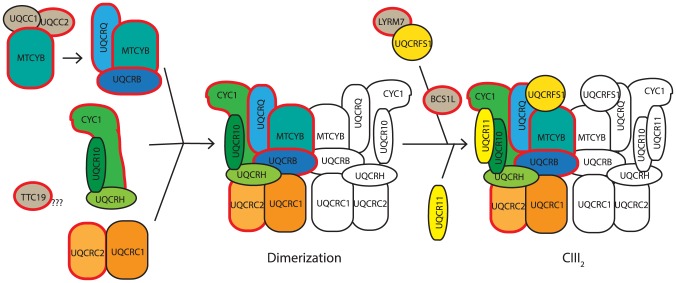
Proposed model of CIII assembly.Complex III assembly begins with the translation activation and/or stabilization of cytochrome b (MTCYB) by UQCC1:UQCC2, which then delivers MTCYB to an assembly intermediate containing UQCRQ and UQCRB. This module combines with a module containing CYC1, UQCRH and UQCR10 and a module containing UQCRC2 and UQCRC1. The resulting subcomplex then dimerizes. UQCRFS1 is bound and stabilized by the CIII assembly factor LYRM7, before being incorporated into CIII with the aid of the assembly factor, BCS1L. Finally UQCR11 is added, forming the complete CIII2. Assembly factors are indicated in gray. Proteins in which mutations are associated with complex III deficiency are bordered in red. The role of TTC19 is yet to be elucidated, although it is likely to be involved in early complex III assembly. Model adapted and updated from [67].